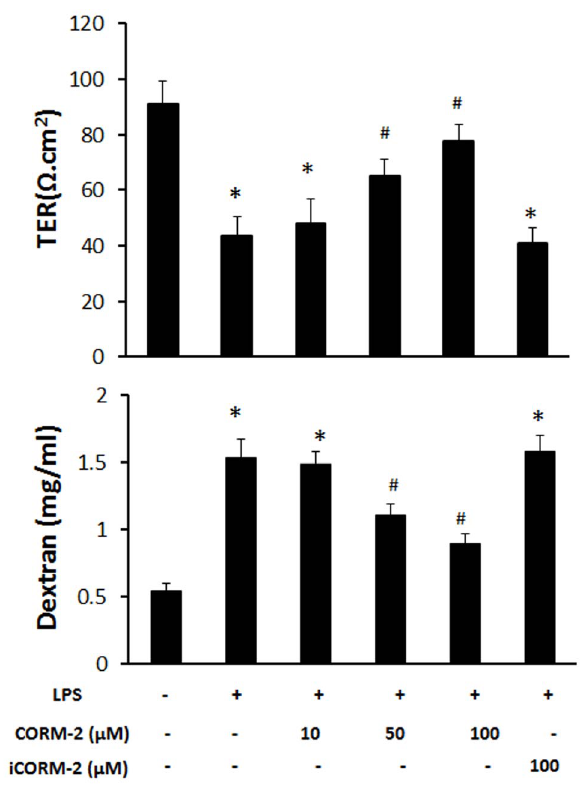
Figure 2. Effect of CORM-2 on the permeability of LPS-treated IEC-6 cell monolayer. When cells reached confluence in the transwell system, CORM-2 was added and incubated for 1 h. The cells were washed and treated with 50 m g/ml LPS for 24 h. (a) Mean 6 SD of TER values from 3 independent experiments are shown. (b) Permeability of FITC-dextran across the cell monolayer indicated CORM-2 could decrease the LPS-induced increase. Results are the mean 6 SD of 3 independent experiments. *ANOVA test, p , 0.05 as compared to control group, # p , 0.05 as compared to LPS group.